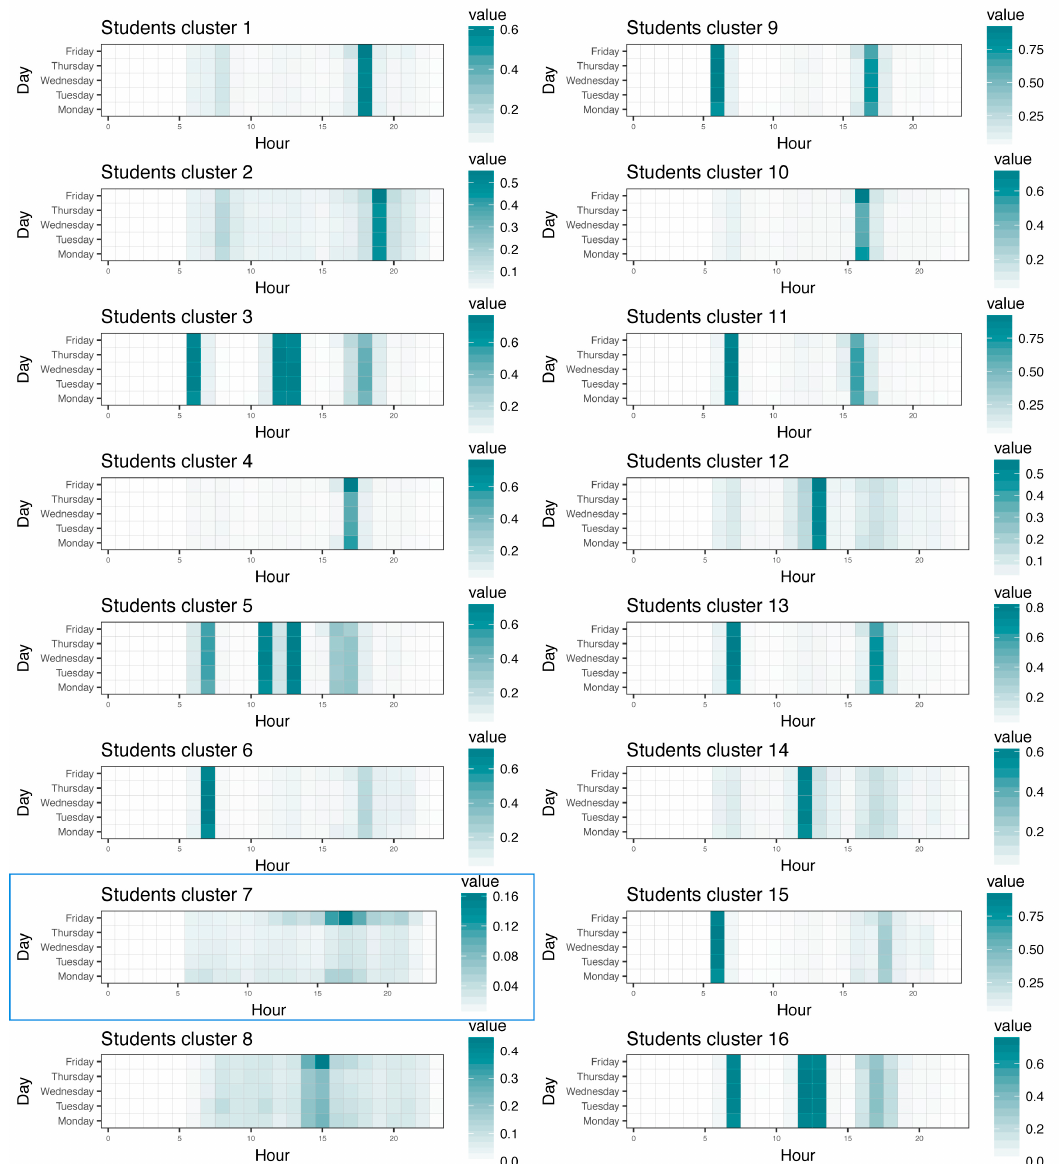
ff erent clusters of students. ISPRS Int. J. Geo-Inf. 2019 , 8 , x FOR PEER REVIEW